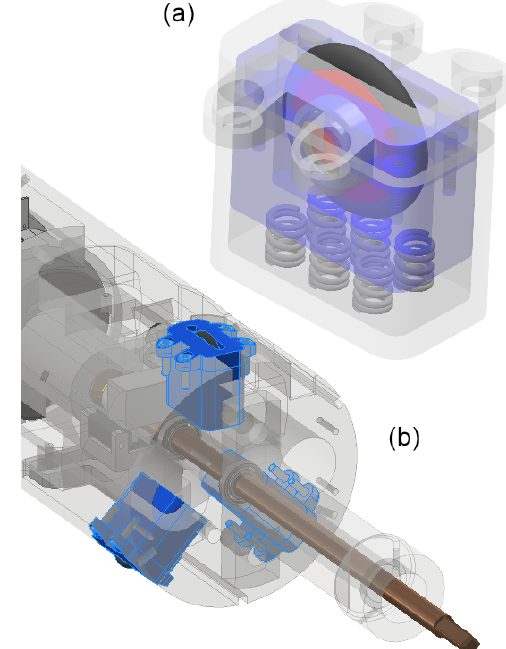
Figure 2. Rendering of the stabilizing wheel (a) and a detail of its mounting in the base of the probe (b) . The wheel assemblies are highlighted in blue.